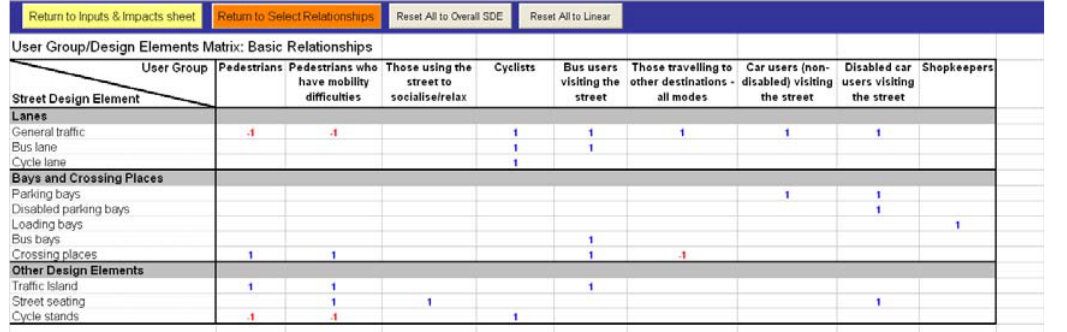
Figure 4. Assessment of potential design elements Source: Jones and Paskins (2008a), Figure 14